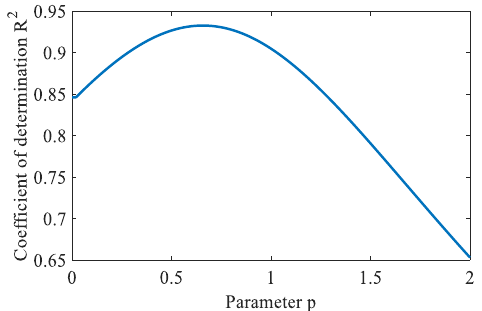
Figure 17. R 2 values of FCM_NNS based F index with different parameter p .